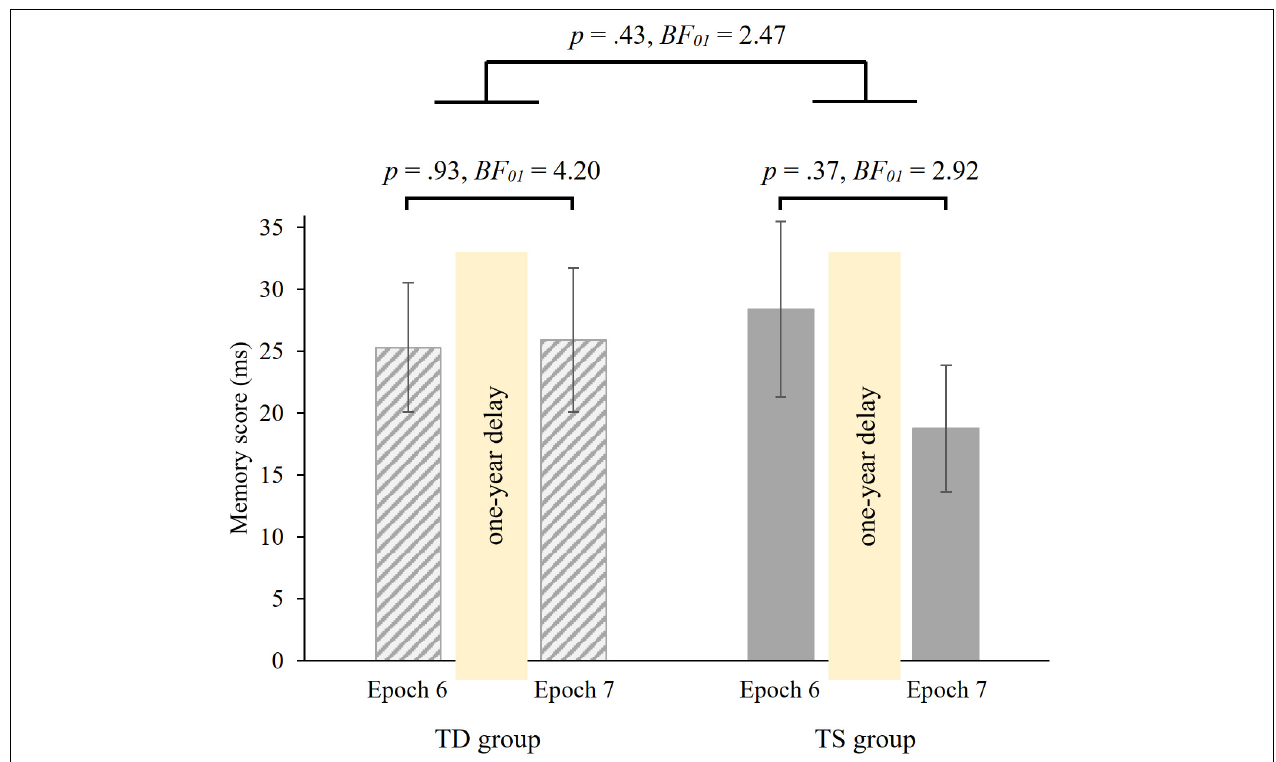
FIGURE 5 | 1-year retention of knowledge of probability-based regularities in the TD and TS groups. Memory scores were measured by RT values for the last epoch of the Testing Phase (Epoch 6) and the first epoch of the Retesting Phase (Epoch 7). Error bars denote the standard error of